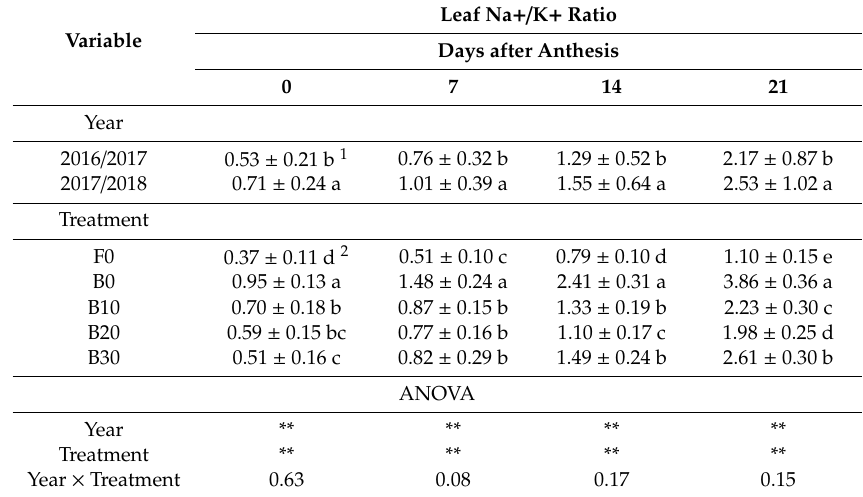
Table 8. Main e ff ects of year and treatment on leaf Na + / K + ratio at 0, 7, 14, 21 days after anthesis.